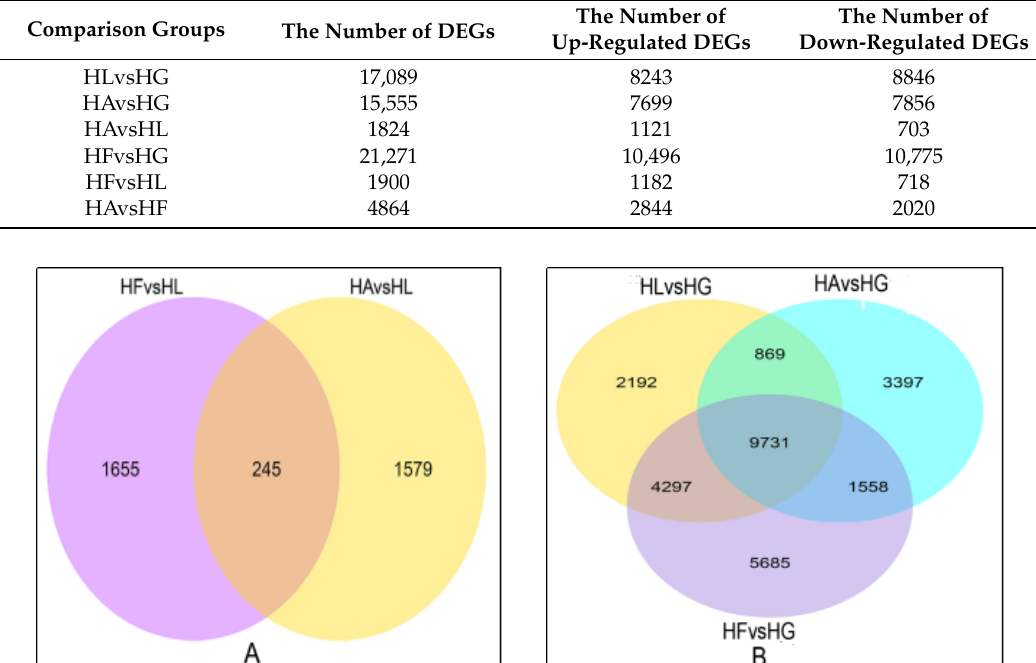
Table 3. Number of DEGs (differentially expressed genes) in different comparison groups.